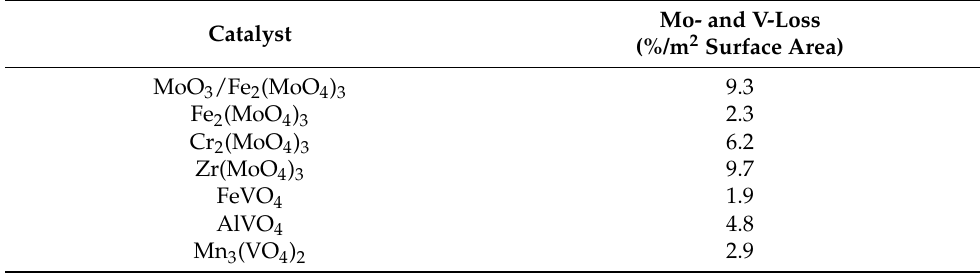
Table 2. Volatilization of Mo and V measured in the decrease in their surface areas from different molybdates and vanadates, respectively, under 96 h of MeOH oxidation. T = 300 ◦ C. Feed: 6 vol.% CH 3 OH and 11 vol.% O 2 in inert gas. Flow: 277 mL/min; loading: 30 mg catalyst; particle